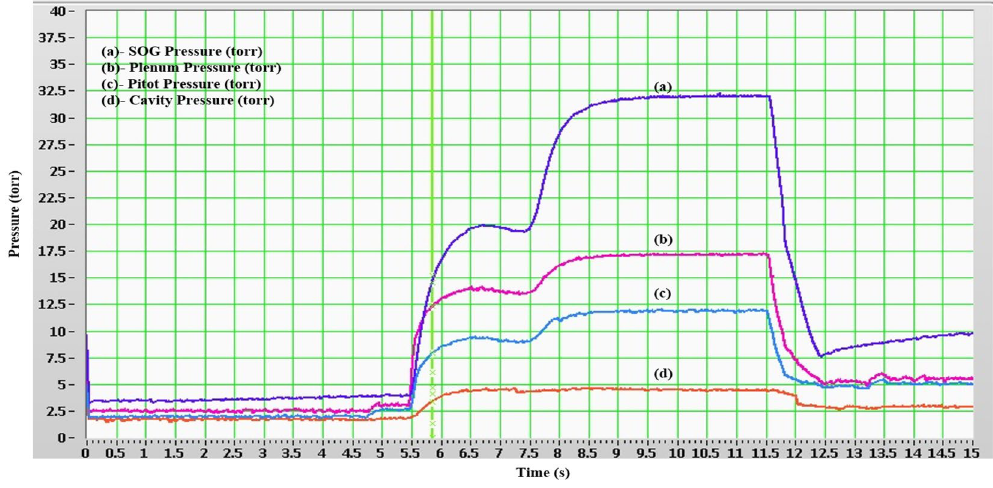
Figure 6. Temporal pressure variations during laser generation.